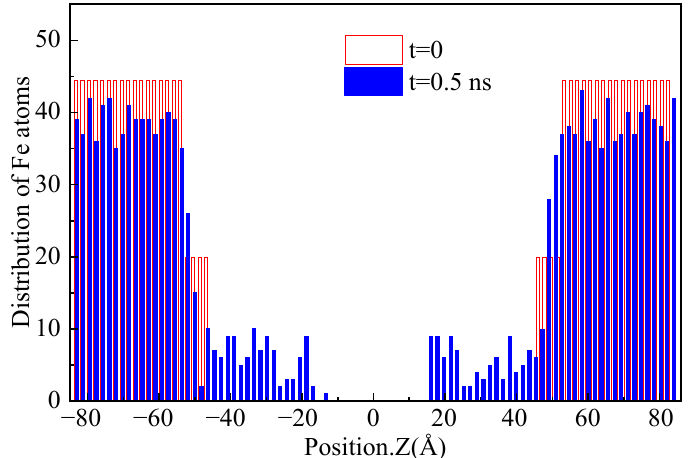
Figure 10. Initial and last distribution of Fe in model C.